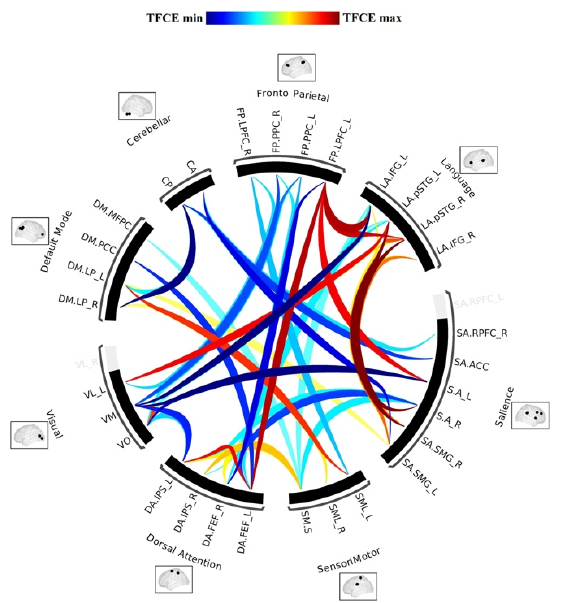
Figure 3. Graph representing the intrinsic functional architecture of the human brain RSNs named connectome.